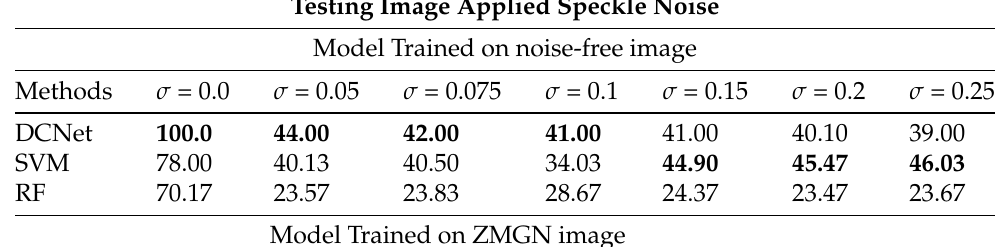
Table 2. Comparison of accuracy value with traditional machine learning on speckle testing image. Bold fonts indicate the best